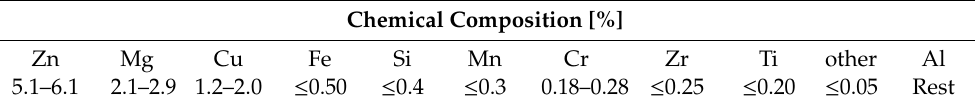
Table 1. Chemical composition of AW-7075 alloy, percentage by